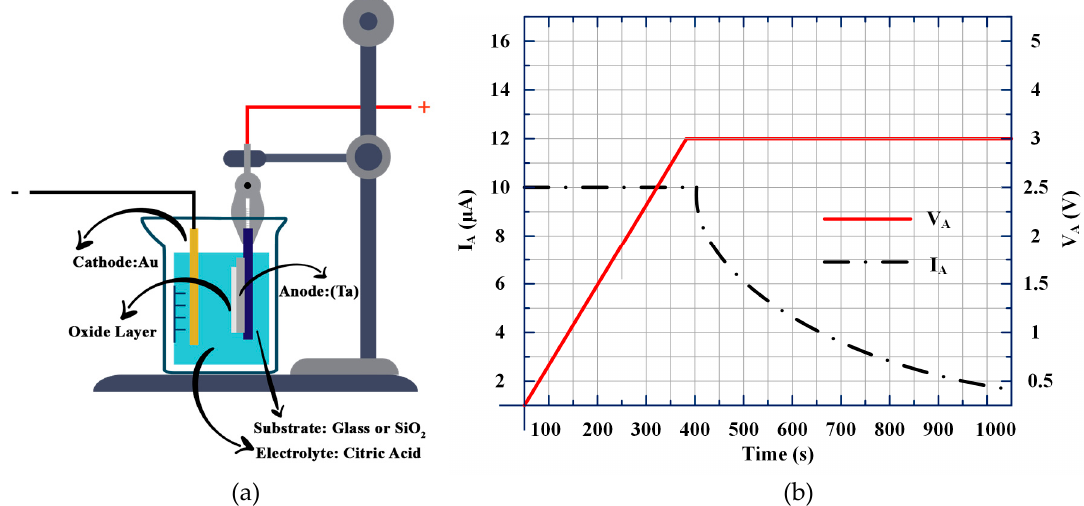
Figure 1. ( a ) Schematic representation of the anodic oxidation process. ( b ) Anodization voltage (V A